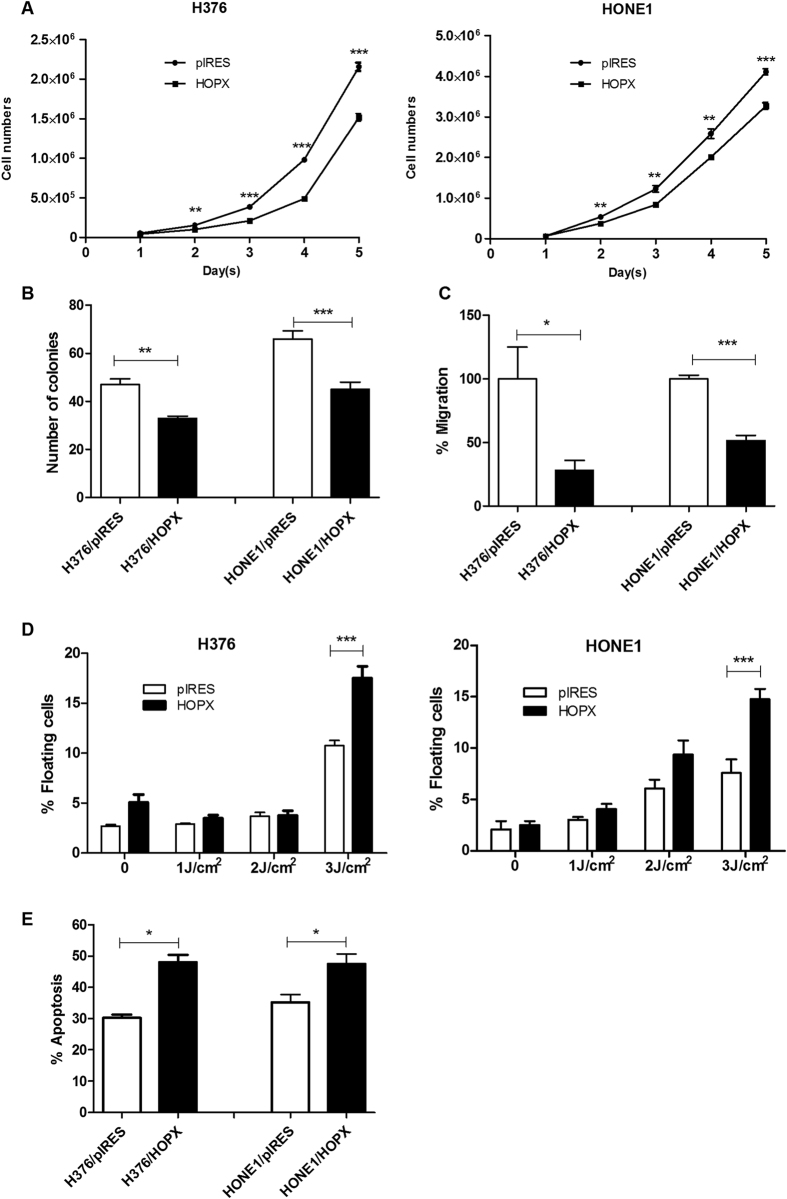
Tumour suppressive effects of HOPX in OSCC and NPC cells.The proliferation (A), plating efficiency (B) and migration (C) of HOPX expressing H376 OSCC and HONE1 NPC cells was significantly reduced compared to vector transfected controls. HOPX expressing H376 and HONE1 cells were more sensitive to DNA damage induced by UVA irradiation as determined by the percentage of floating cells in the culture dish (D) after 24 hours and enhanced in apoptosis as determined by flow cytometric analysis of Annexin V staining 24 hours after irradiation (3 J/cm2 UVA; E). Results are shown as mean ± SD values of triplicates. *ρ < 0.05, **ρ < 0.01 and ***ρ < 0.001.